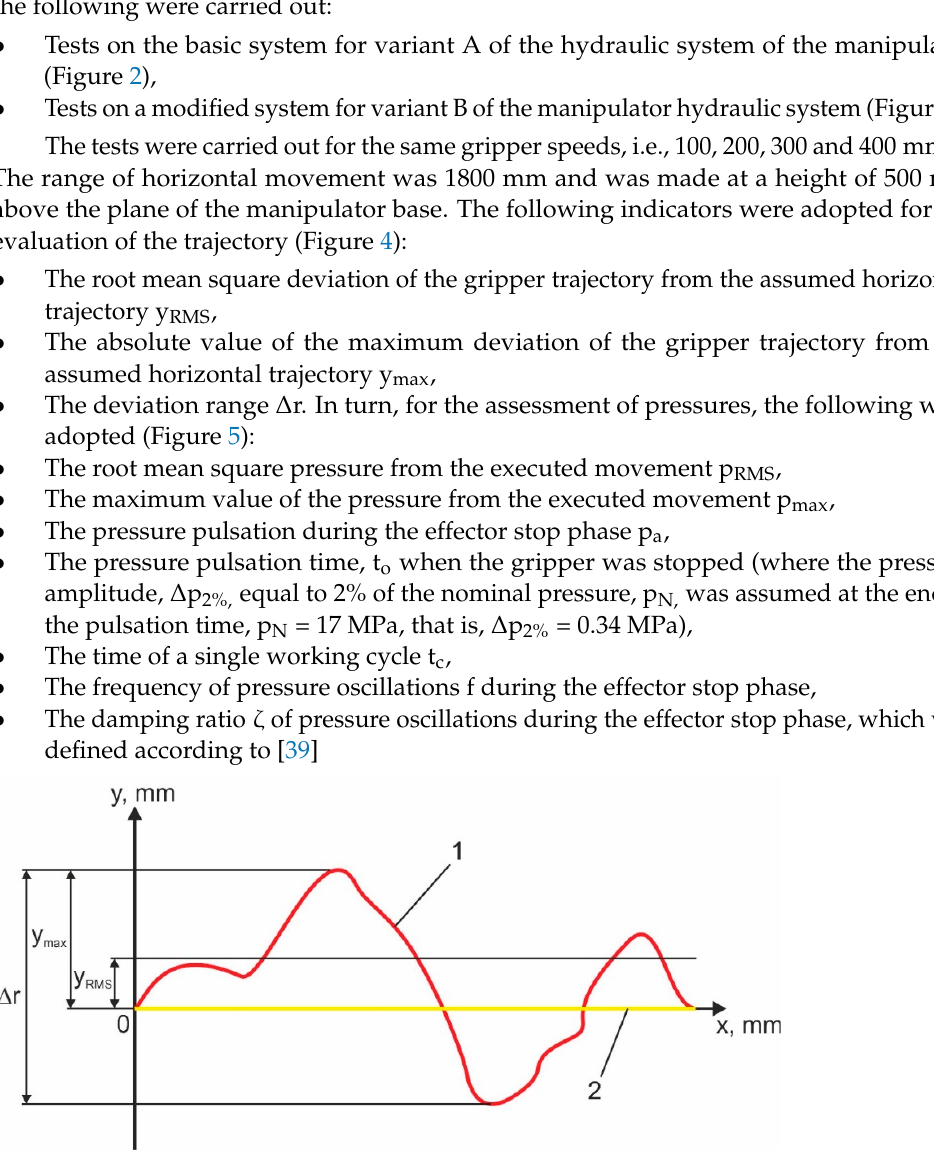
Figure 5. The scheme of indicators to evaluate pressures. In order to implement the assumed horizontal trajectory, signals for controlling the boom and arm actuators of the tested manipulator were developed. They were based on the diagram in Figure 6. Based on the knowledge of the x, y position coordinates of the gripper, the angles ϕ 1 and ϕ 2 were determined; the knowledge of which allowed determi- nation of the necessary angular velocities 𝜑(cid:4662) 1 and 𝜑(cid:4662) 2 , the velocity of the piston rods of the boom, 𝑠(cid:4662) 1 , and the arm, 𝑠(cid:4662) 2 , and, consequently, the required flow of these Q 1 and Q 2 cylin- ders. Figure 6. Scheme of determining the control signals for the piston rod movement of the boom and arm hydraulic cylinders. According to the diagram (Figure 6), the first angles ϕ 1 and ϕ 2 were determined. They were determined based on the task of inverse kinematics [40], according to the scheme in Figure 7. It was assumed that the angle ϕ 3 between the arm and forearm was unchanged during the motion and equaled 180°.